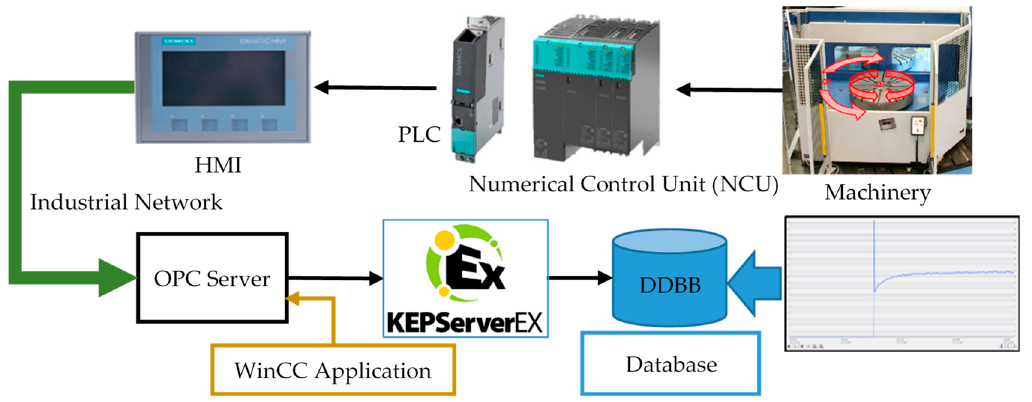
Figure 3. Implemented Open Platform Communications (OPC) scheme and database.